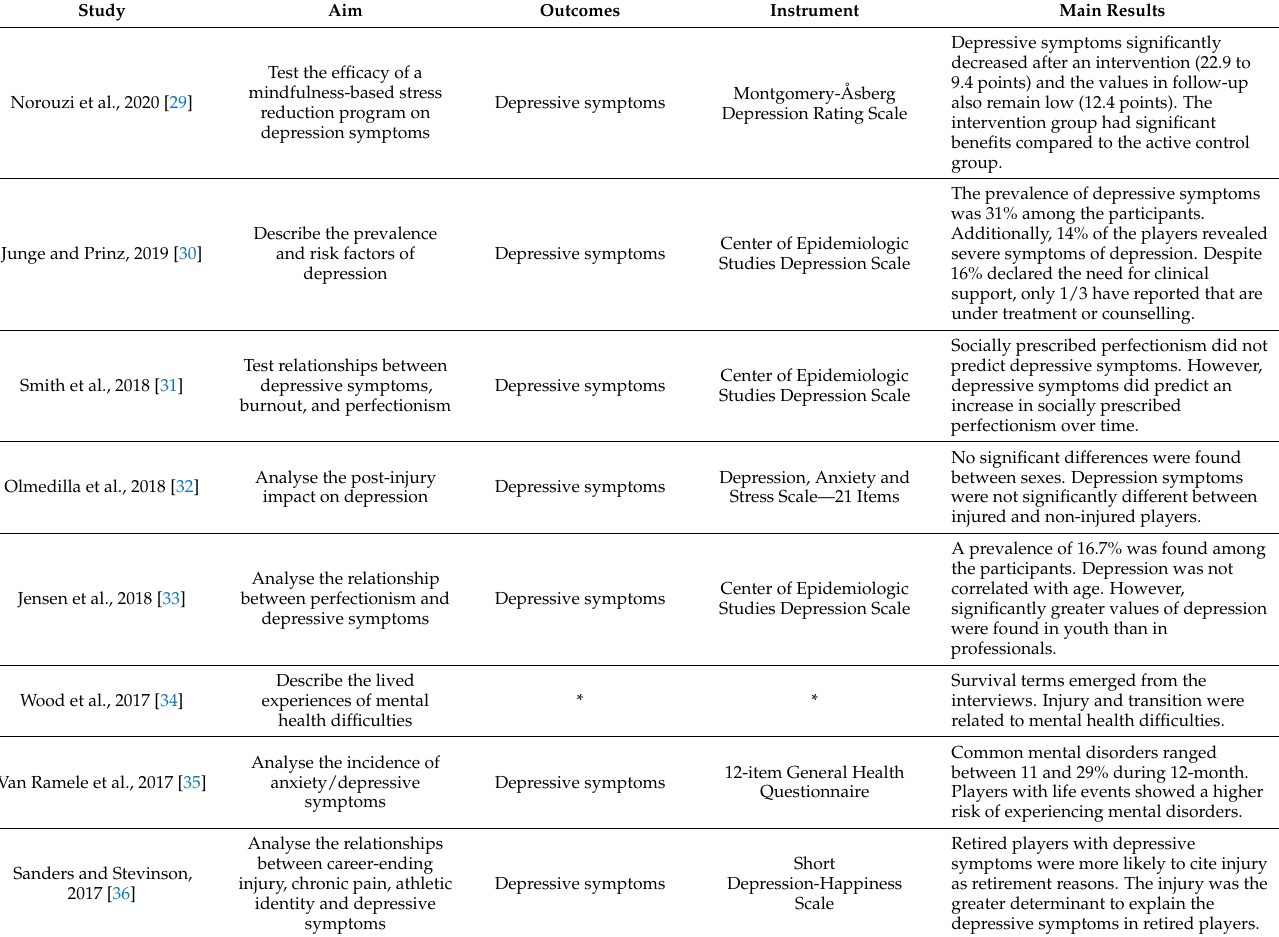
Table 3. A qualitative synthesis of the studies related to depression and depressive